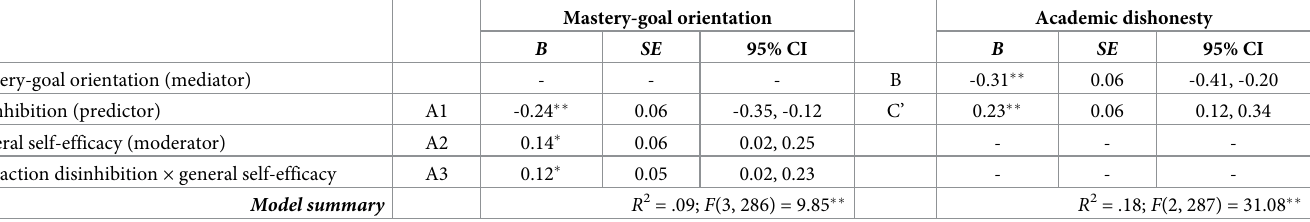
Table 3. Estimates for moderated mediation for the relation between disinhibition, mastery-goal orientation, general self-efficacy, and academic dishonesty in